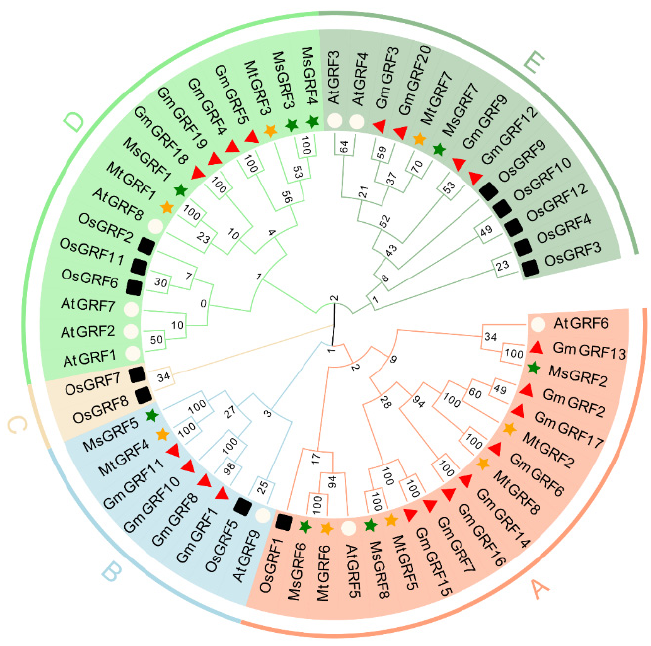
Figure 2. Phylogenetic analysis of GRF families across Medicago , Arabidopsis , G. max and O. sativa . Full-length protein sequences of GRFs were constructed using MEGA-X based on the Neigh- bor-Joining (NJ) method; bootstrap was 1000 replicates. Subfamilies were highlighted with differ- ent colors. The green solid pentagrams, orange solid pentagrams, hollow circles, red triangle and black square represent GRF proteins from M. truncatula (Mt), M. sativa (Ms), A. thaliana (At), G. max (Gm) and O. sativa (Os), respectively.